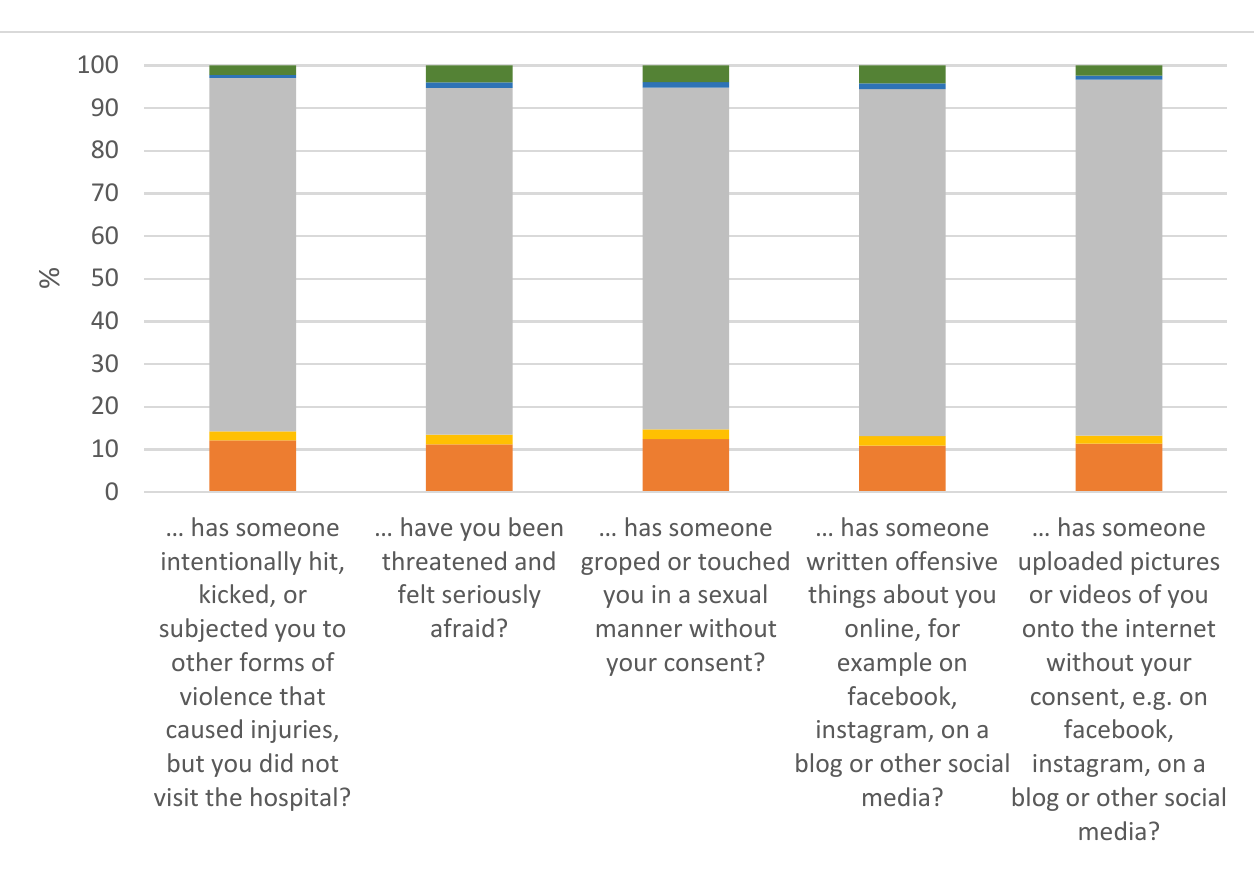
Figure 6. Changes in the frequency of victimization since COVID-19.